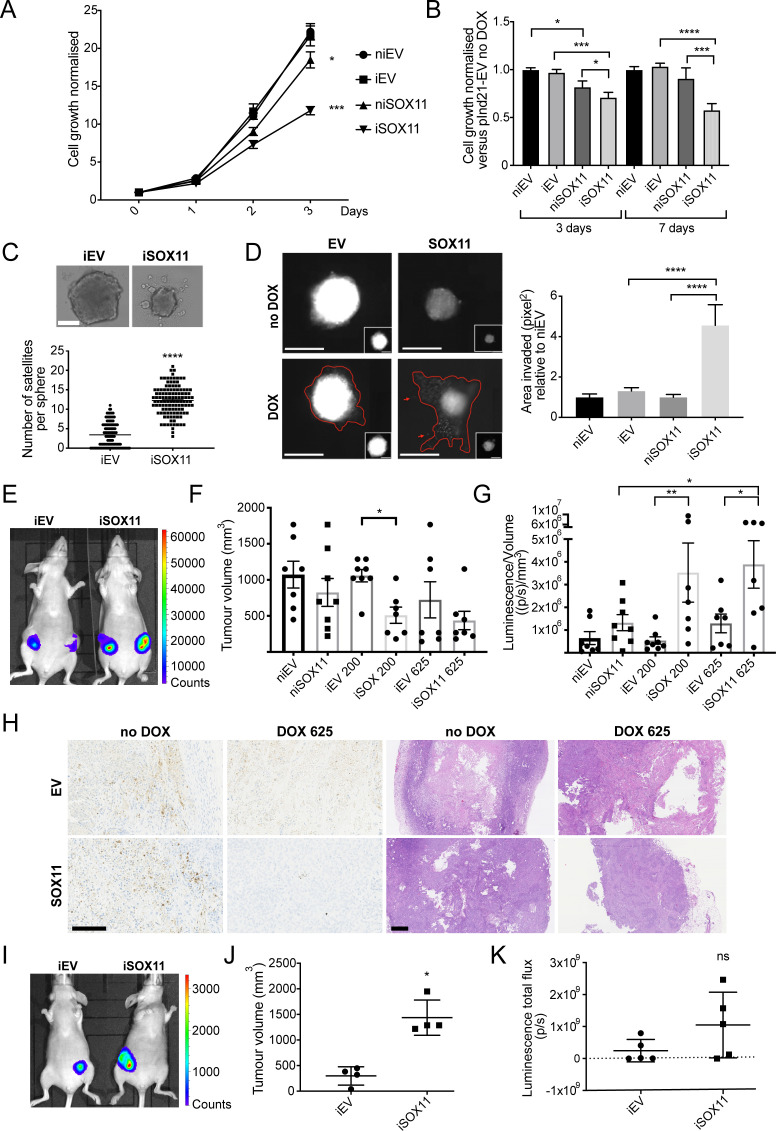
DCIS cells expressing SOX11 grow more slowly and form more invasive spheroids.(A) Cell growth assays results for iEV or iSOX11 DCIS cells (induced with 1 μM DOX for 72 hr). Experiments were performed five times. Error bars represent SEM. *p = 0.0450 and ****p < 0.0001. (B) Cell growth assays results for spheroid formed with iEV or iSOX11 DCIS cells induced with 1 μM DOX for 3 or 7 days. Experiments were performed three times. Error bars represent SEM. p-values (3 days): *p = 0.0374 (niEV vs niSOX11), *p = 0.0221 (niSOX11 vs iSOX11) ***p = 0.0002. p- values (7 days): ***p = 0.0004 and ****p < 0.0001 (C) Examples of DCIS iEV and DCIS iSOX11 spheroids grown on low attachment plates. Graph shows the number of microsatellites per sphere. ****p < 0.0001. (D) Invasion assay after overlaying niEV, iEV, niSOX11 and iSOX11 DCIS spheroids with Collagen I. Scale bar: 200 μm. Graph shows the area invaded in pixel2 normalised against niEV. Both ****p < 0.0001. (E–G) IVIS imaging, tumour volumes and luminescence total flux/volume results after mammary fat pad xenografts. p-value in F: *p = 0.0331. p-values in G: *p = 0.0252 (niSOX11 vs iSOX11 625ppm), *p = 0.0285 (iEV 625 ppm vs iSOX11 625 ppm), **p = 0.0082. (H) Representative images of IHC staining to detect Cleaved Caspase three and H and Es of tumours resected from mice injected with iEV and iSOX11 cells. Scale bar: 500 μm. (I–K) IVIS imaging, tumour volumes and luminescence total flux after mammary intraductal injection (MIND) xenografts. *p = 0.0286 (U Mann Whitney). DOX: doxycycline, IHC: Immunohistochemistry.